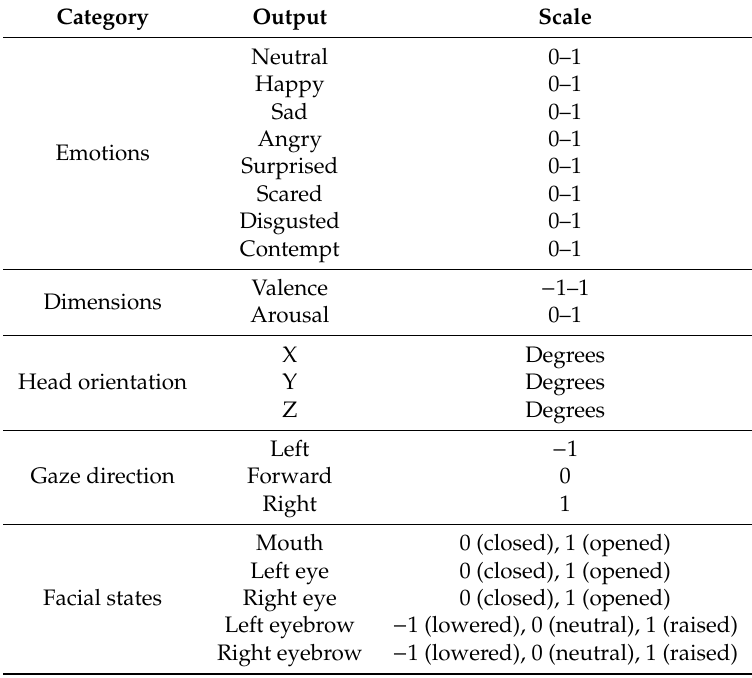
Table 2. Category, outputs, and scale of FaceReader ™